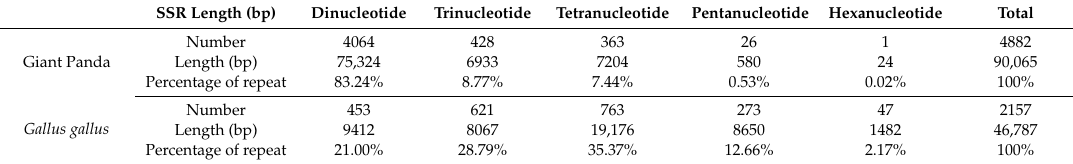
Table 1. Distribution of polymorphic simple sequence repeats (SSRs) in the giant panda and Gallus gallus . SSR Length (bp) Dinucleotide Trinucleotide Tetranucleotide Pentanucleotide Hexanucleotide Total Giant